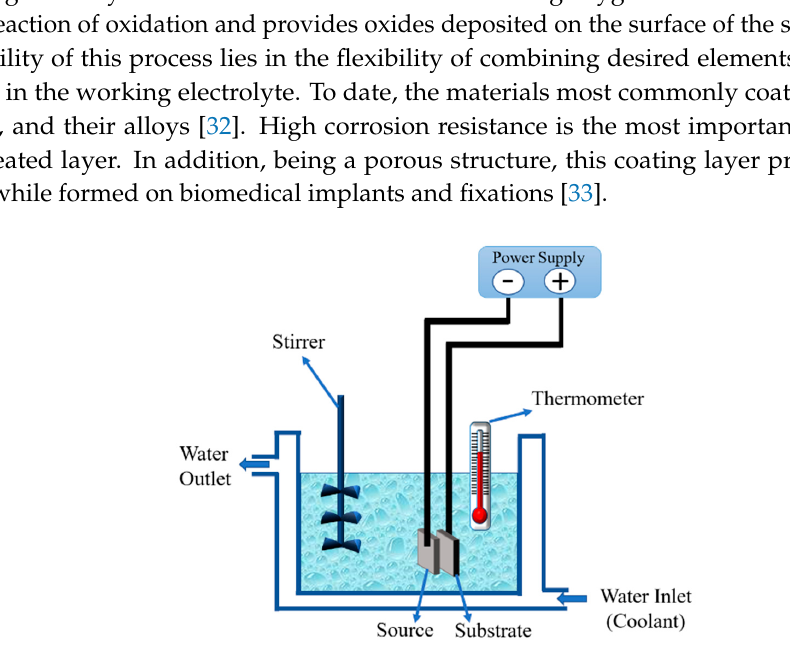
Figure 3. Schematic view of micro-arc oxidation (MAO) process.